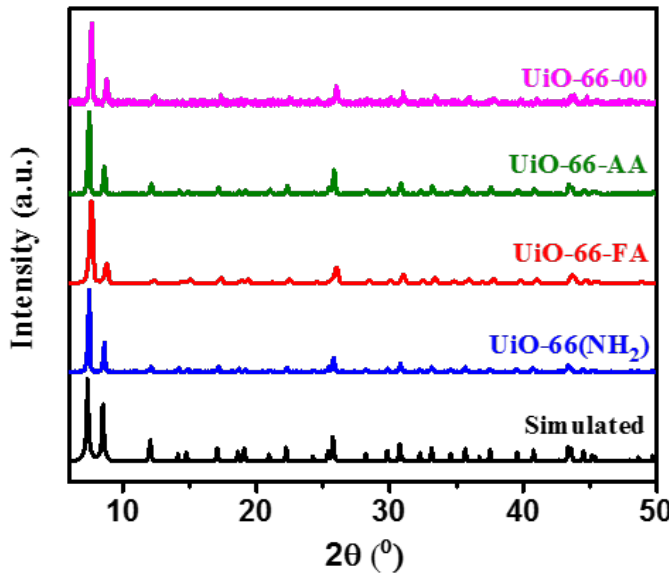
Figure 1. PXRD patterns of the synthesized MOFs compared to the simulated one.